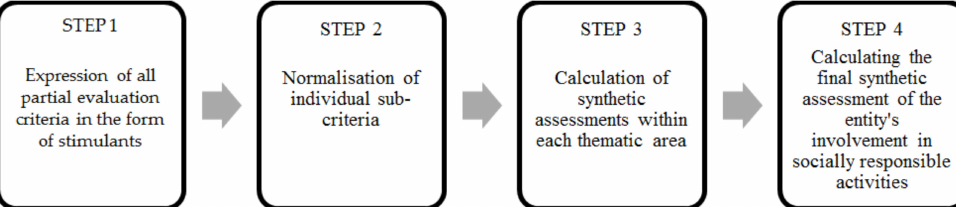
Figure 2. Diagram of the process for obtaining a synthetic evaluation of a company’s involvement in socially responsible